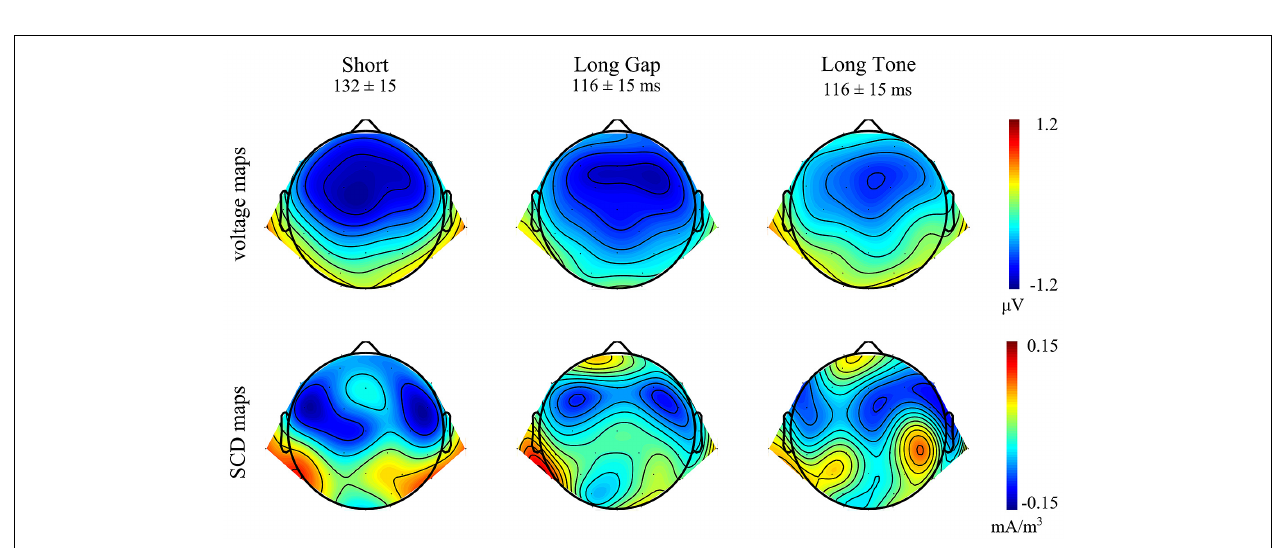
FIGURE 2 | Grand-average ERP waves at FC1, Fz, FC2, LM, and RM (from left to right) elicited by deviant tone-pairs (gray dotted line) and by physically identical standard tone-pairs (gray solid line), separately for each condition: Short (top), Long Gap (middle), and Long Tone (bottom). The corresponding deviant-minus-standard